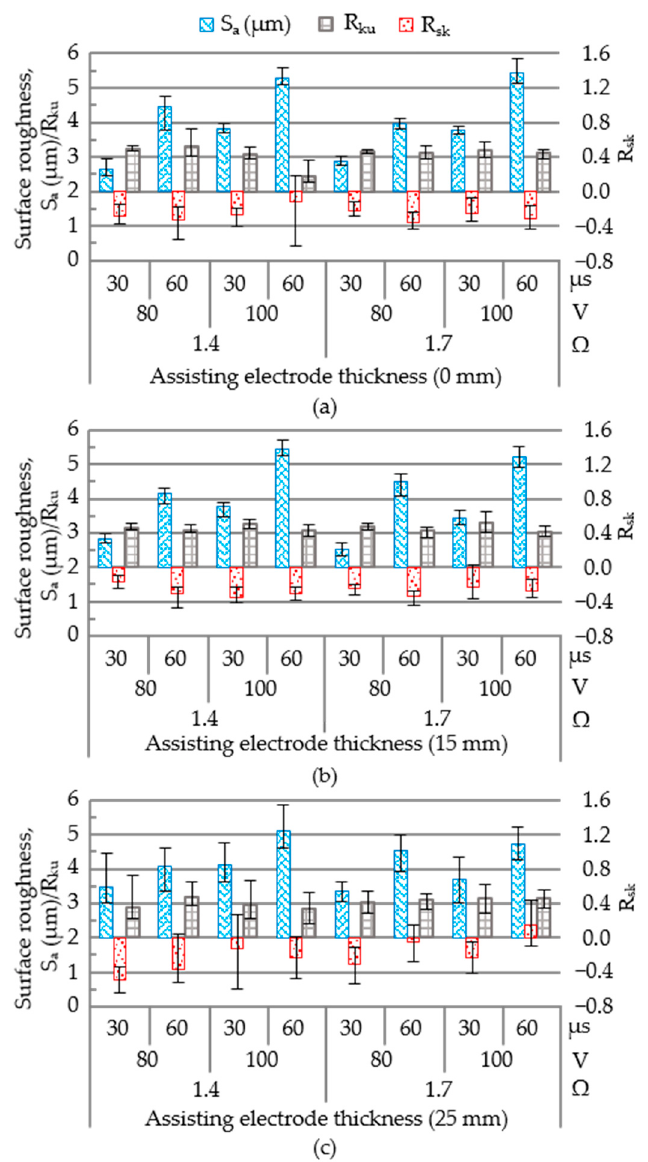
Figure 13. Surface roughness of polycrystalline silicon following WEDM processing: ( a ) without an assisting electrode; and with electrodes of ( b ) 15 mm; ( c ) 25 mm.